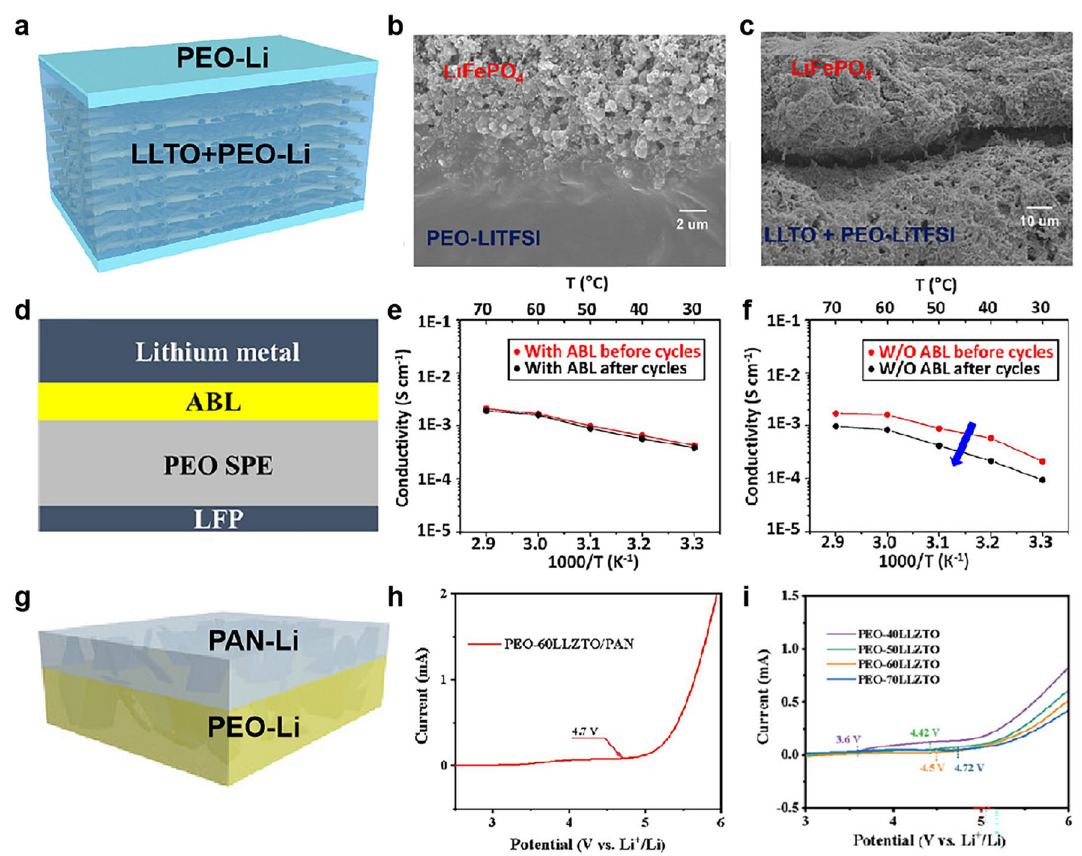
Fig. 11 a Schematic of the PEO/PEO–LLTO/PEO CSEs. b Cross-sectional SEM images of the PEO–LiTFSI–LLTO//LiFePO 4 and c PEO–